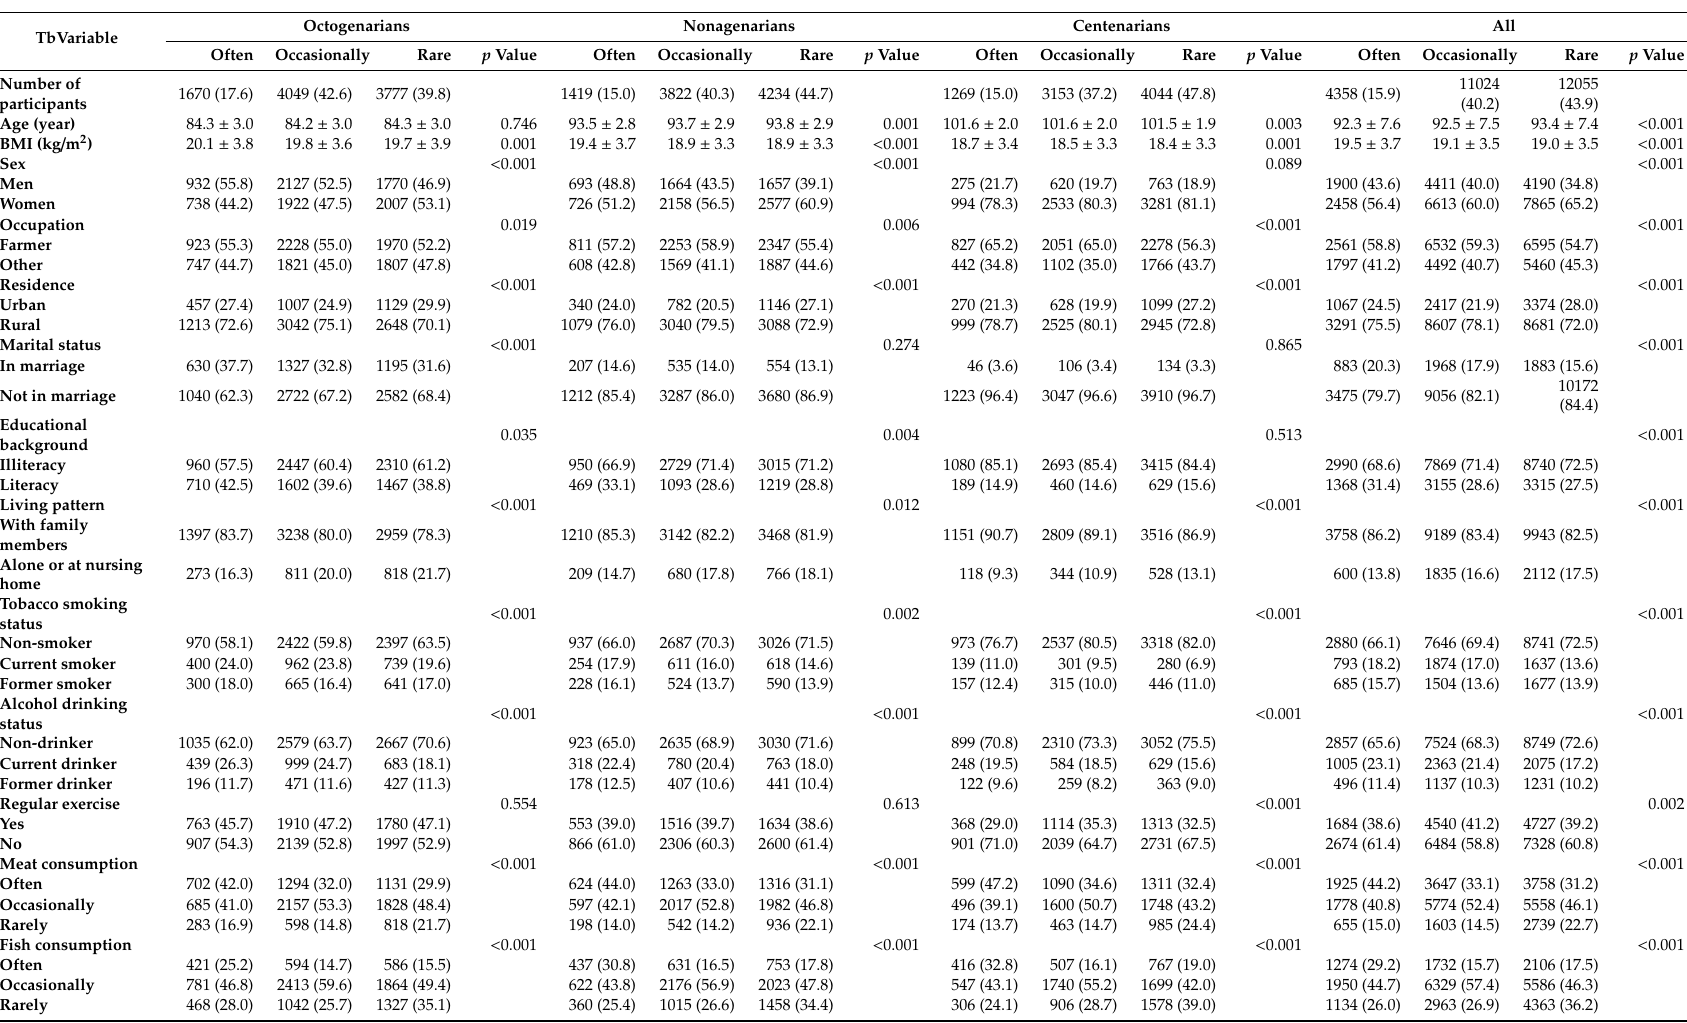
Table 1. Baseline characteristics of the study participants according to garlic consumption by octogenarians, nonagenarians, and